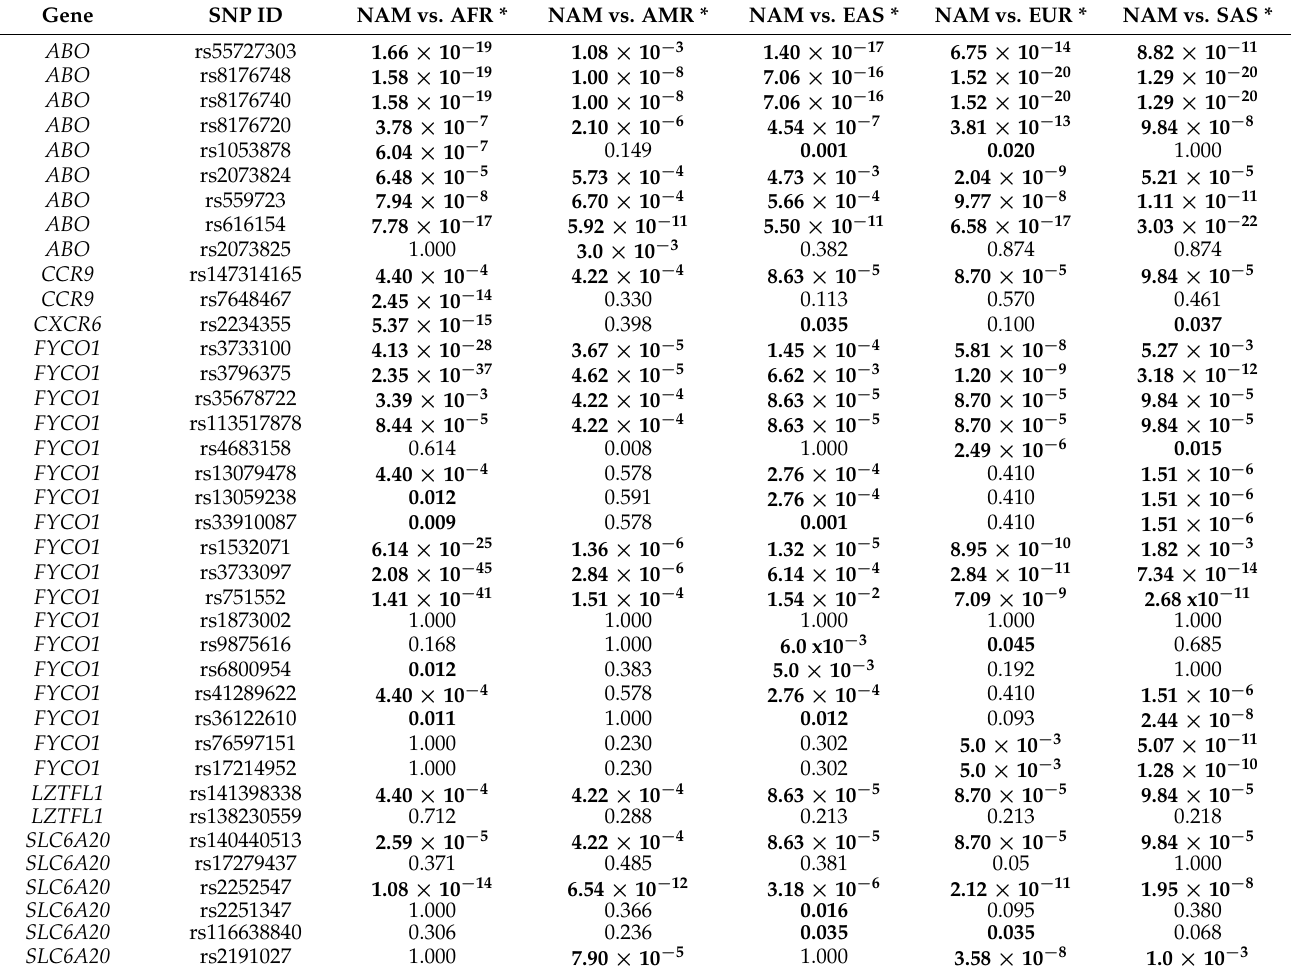
Table 3. Comparison of the allele frequencies between the NAM population and the continental populations (AFR, AMR, EUR, EAS, and